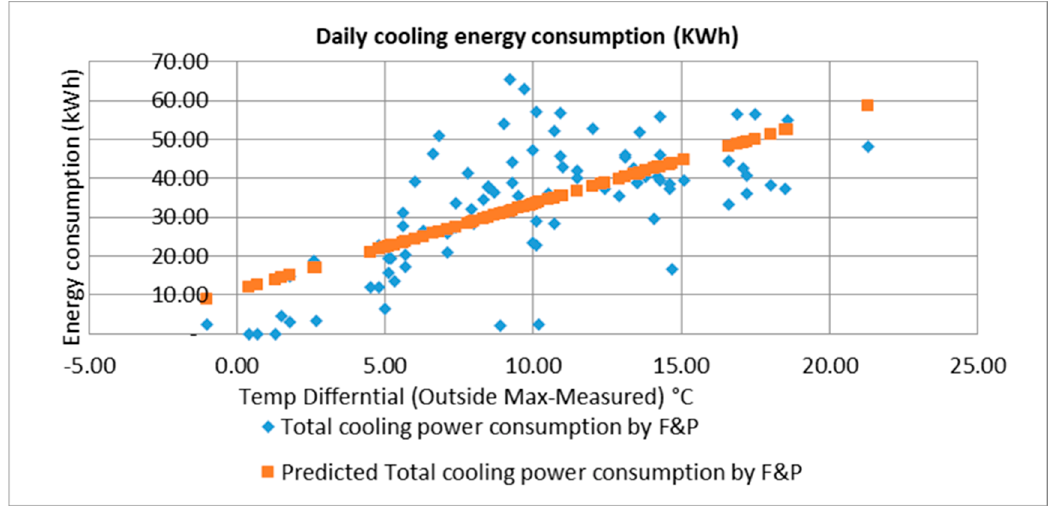
Figure 7. Comparison of cooling energy consumption and temperature differentials. Daily cooling energy consumption vs. temperature differential (outside max—measured in the greenhouse).